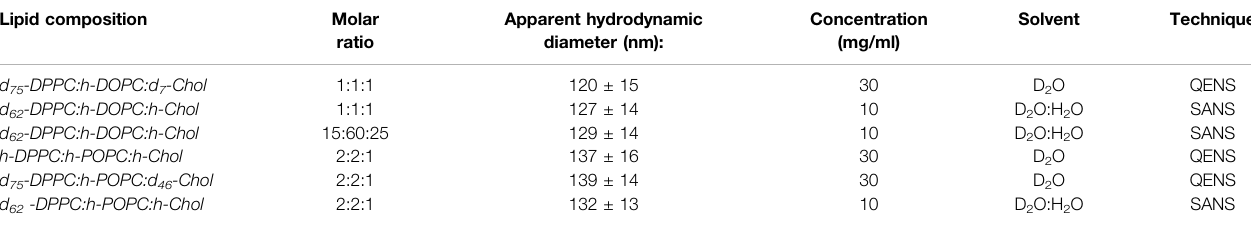
TABLE 1 | Sample characteristics post preparation. Lipid composition Molar